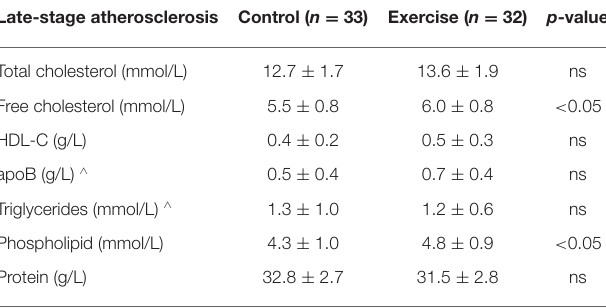
TABLE 4 | The effect of exercise on the lipid profile of the late-stage atherosclerosis mouse model. Late-stage atherosclerosis Control ( n = 33) Exercise ( n = 32) p -value